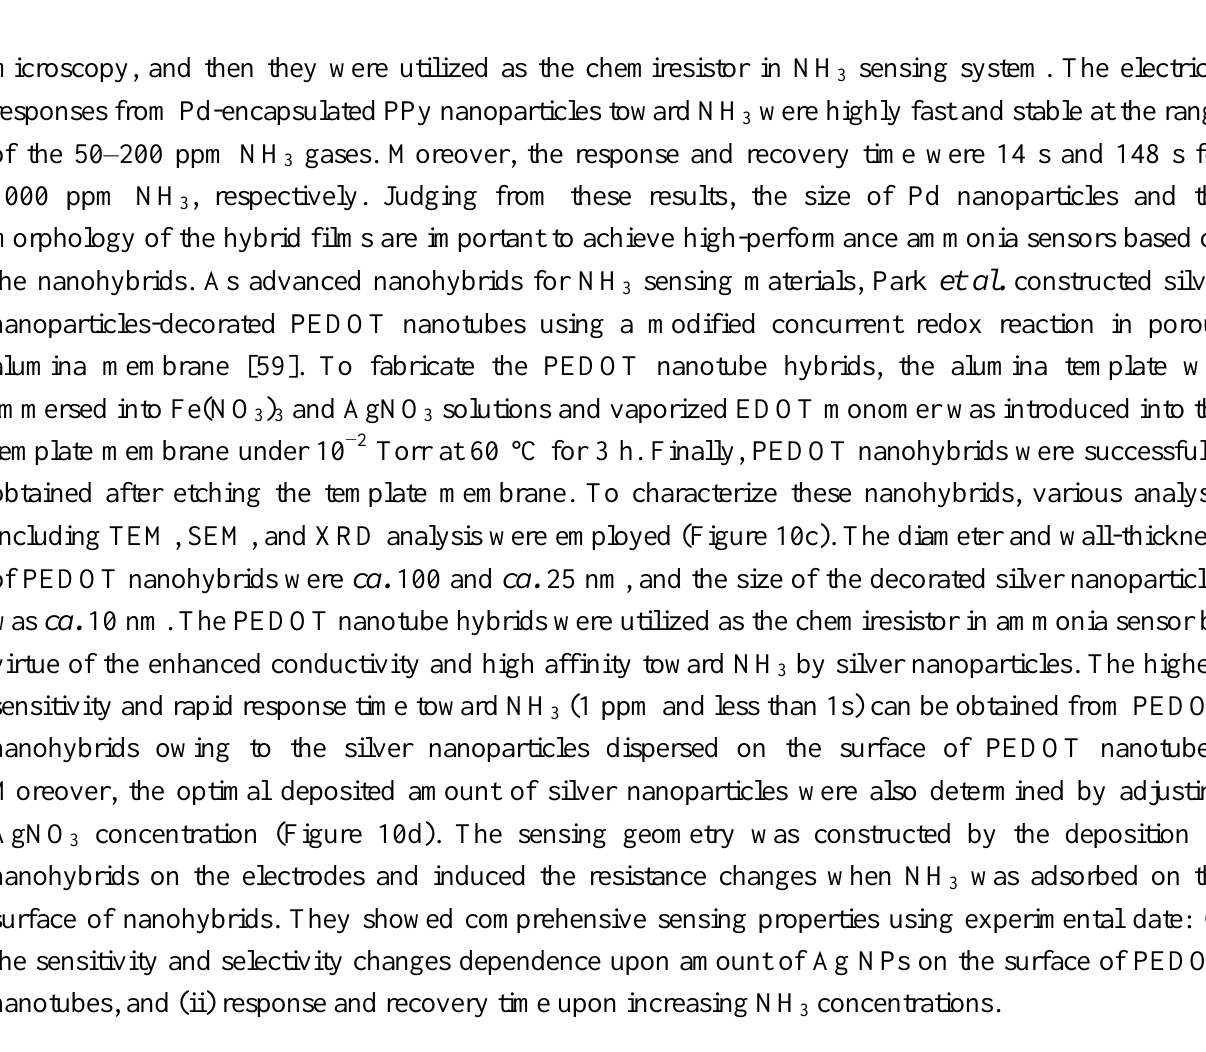
Figure 10. ( a ) TEM image of PPy/Ag-AgCl nanotubes; ( b ) Response of (i) PPy